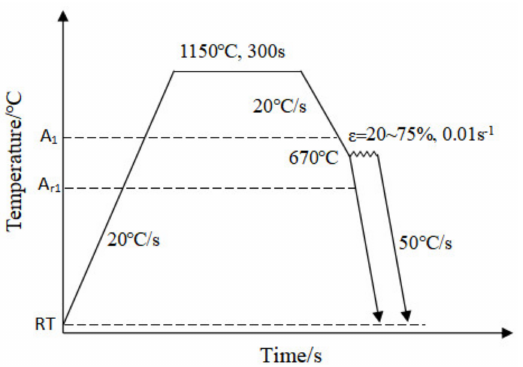
Figure 1. Schematic illustration of thermo − mechanical processing. The dog-bone-shaped specimens, with a gauge dimension of 10 mm × 5 mm × 2 mm (length × width × thickness), were machined and tensiled at room temperature with